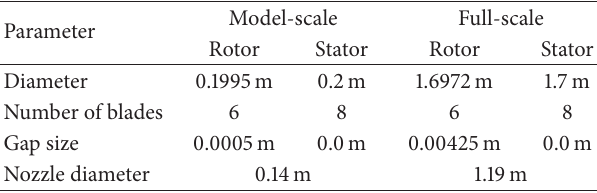
Table 2: Full-scale and model-scale characterstics of